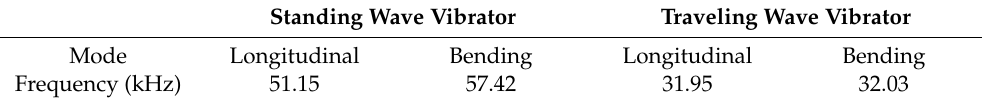
Table 3. Resonance frequencies of longitudinal and bending